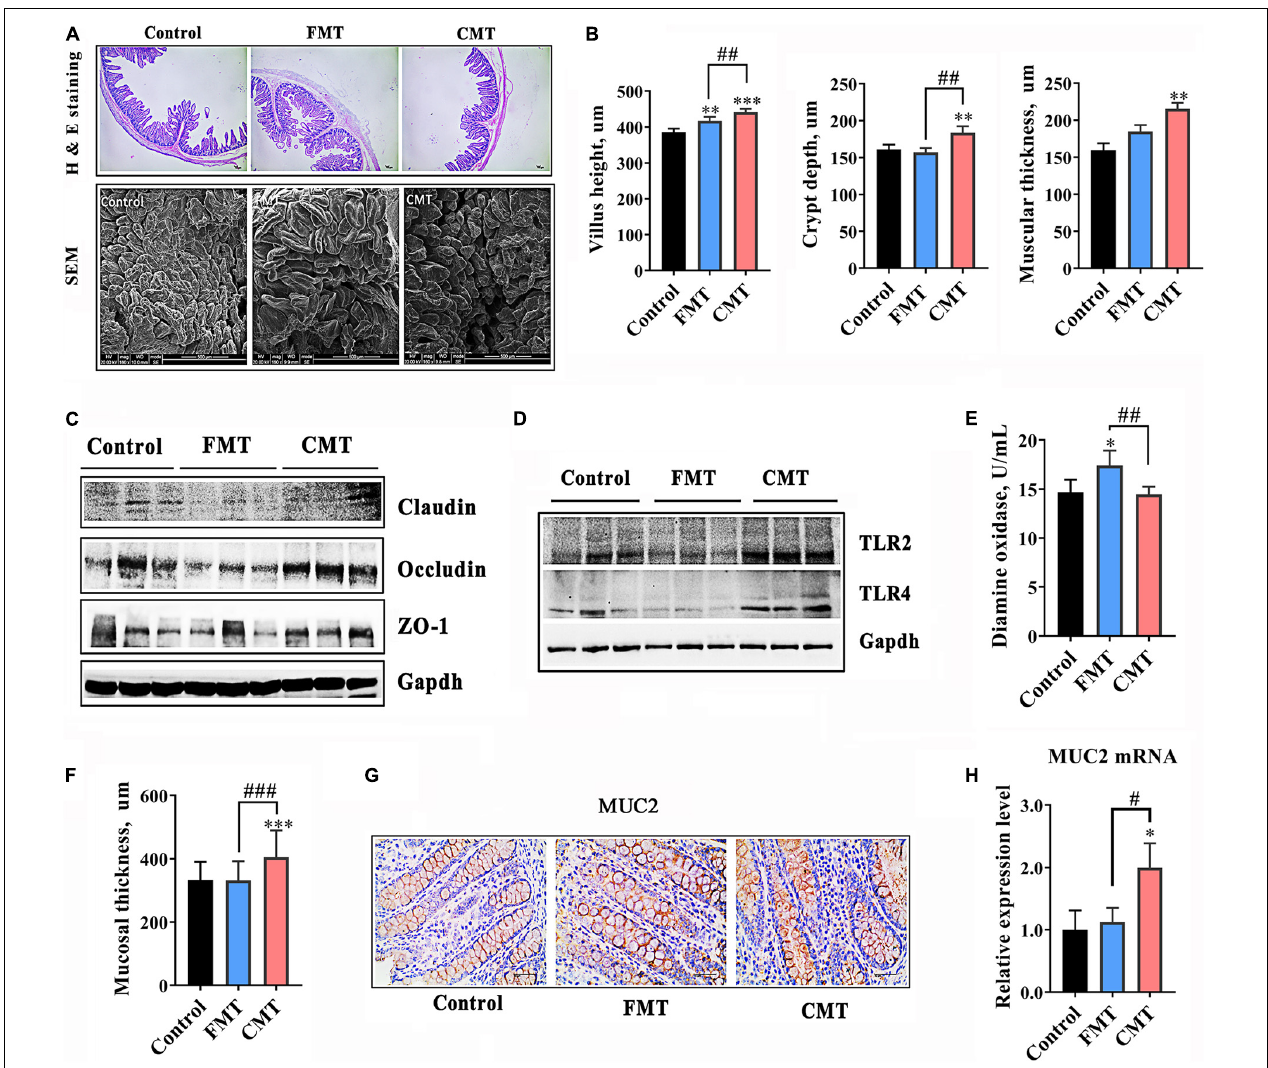
FIGURE 3 | CMT improved development and immune function of the gut in piglets. (A) Hematoxylin-eosin staining images (40 × magnification) and scanning electron microscope images (300 × magnification) of ileal sections from piglets on day 28. (B) Development index of the ileum (height of ileal villi, depth of ileal crypts, and muscular thickness). (C) Protein levels of tight junction proteins in the ilea of piglets. The expression levels of proteins were analyzed by western blotting. (D) Protein levels of toll-like receptor 2 and 4 (TLR2 and TLR4) in the ilea of piglets. (E) Diamine oxidase content in the blood of piglets. (F) Mucosal thickness in the colons of piglets. (G) Immunohistochemical staining of the Mucin 2 (MUC2) protein in colonic sections. (H) mRNA level of MUC2. The expression level was detected by qRT-PCR ( n = 6). The data are presented as the mean ± S.D. ∗∗∗ Indicates P < 0.001; ∗∗ indicates P < 0.01, and ∗ indicates P < 0.05 compared with the control; ### indicates P < 0.001, ## indicates P < 0.01, and # indicates P < 0.05 between the FMT and CMT